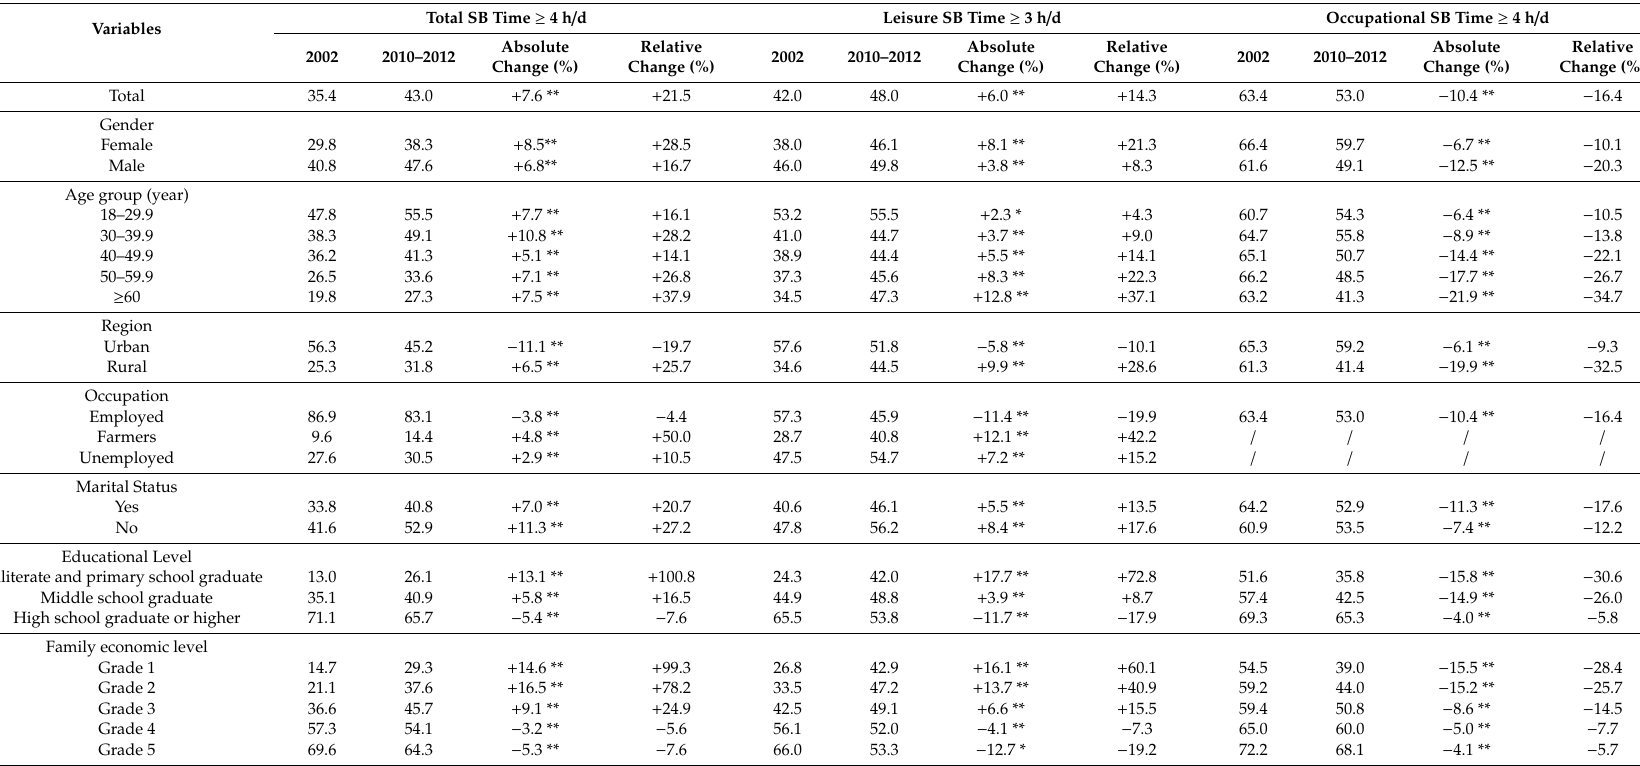
Table 3. Trends § in the prevalence of total SB time ≥ 4 h / d, leisure SB time ≥ 3 h / d and occupational SB # time ≥ 4 h / d among Chinese adults from 2002 to 2010–2012.